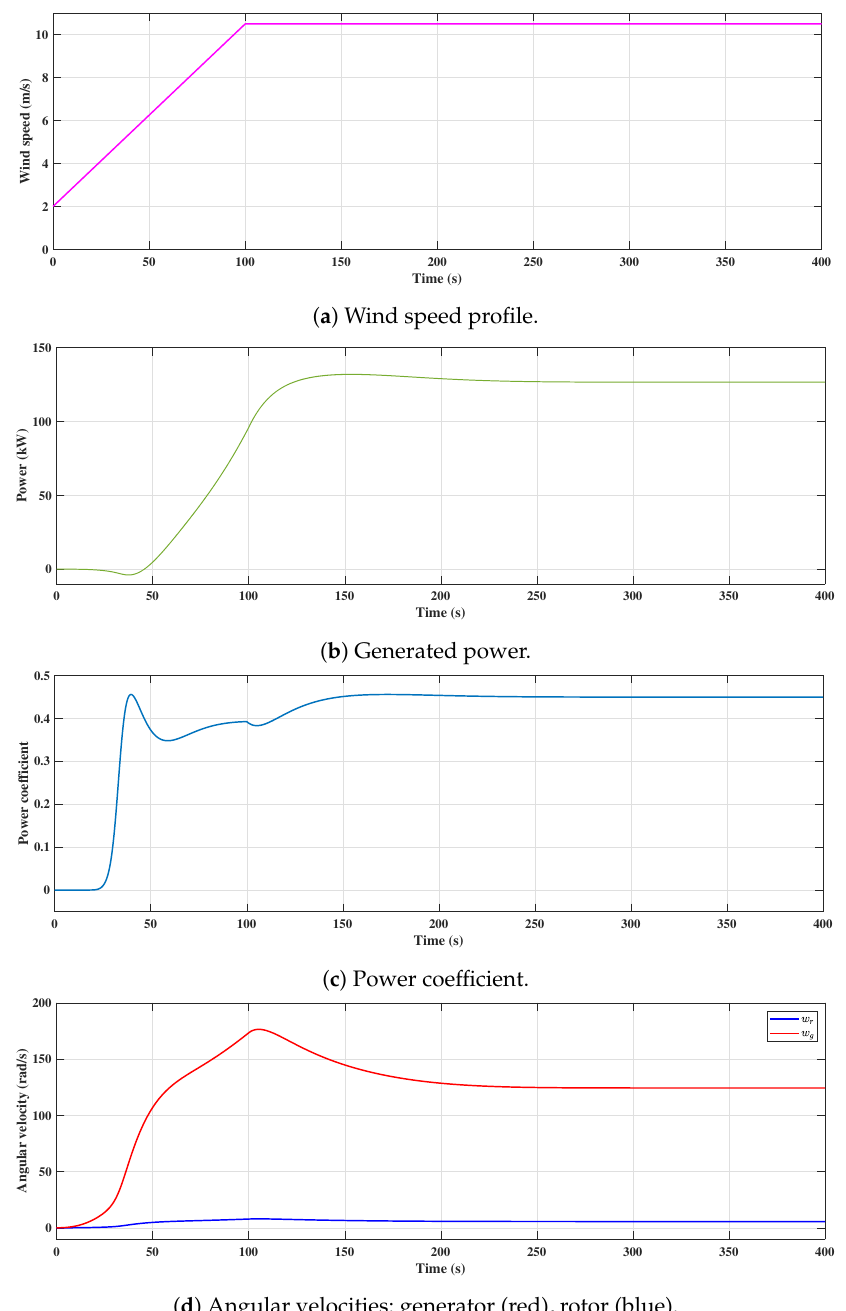
Figure 2. Response of the wind turbine under constant wind